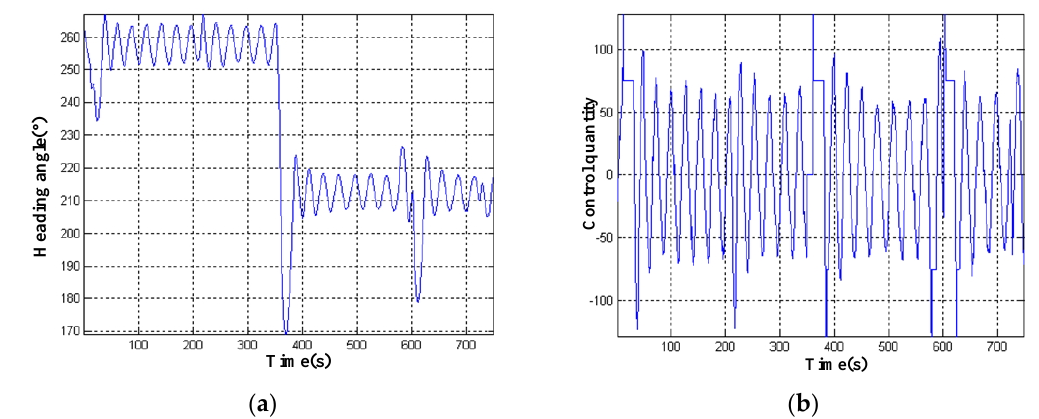
Figure 9. Experiment results of open-loop identification in horizon plane. ( a ) heading angle data; ( b ) control quantity data.